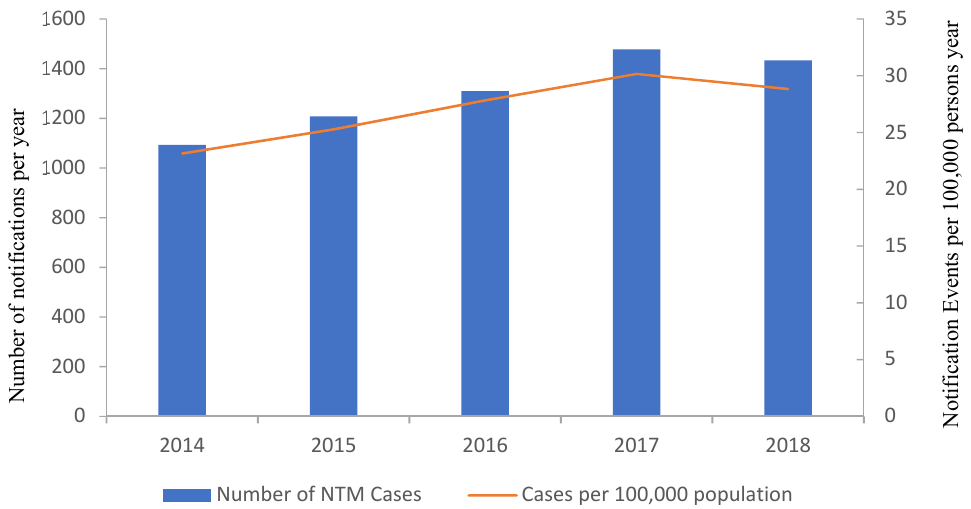
Figure 3. Yearly notifications to Queensland Health of non-tuberculous mycobacterium (NTM) infections for the years 2014 to 2018. The number of notifications per 100,000 population are also listed. Source: https://www.health.qld.gov.au.